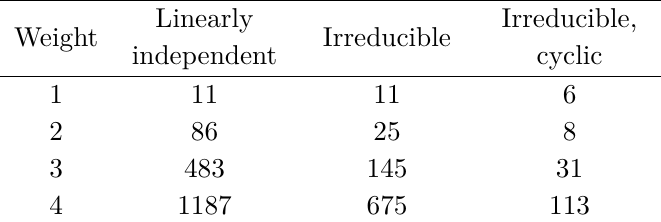
Table 4. Counting of the master integral components at each transcendental weight. The second column corresponds to the number of the Q -linearly independent components. The third column shows the number of irreducible components, i.e. the number of functions in the basis. The fourth column shows the number of functions sufficient to express the master integrals in the cyclic per- mutations D 4 (3.10)